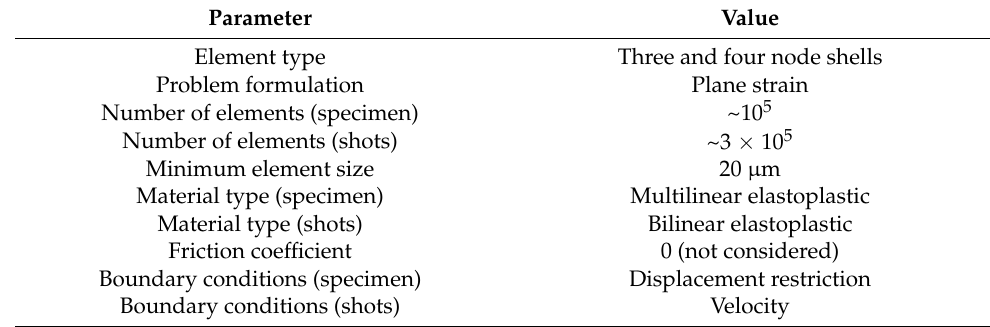
Table 2. FE model essential